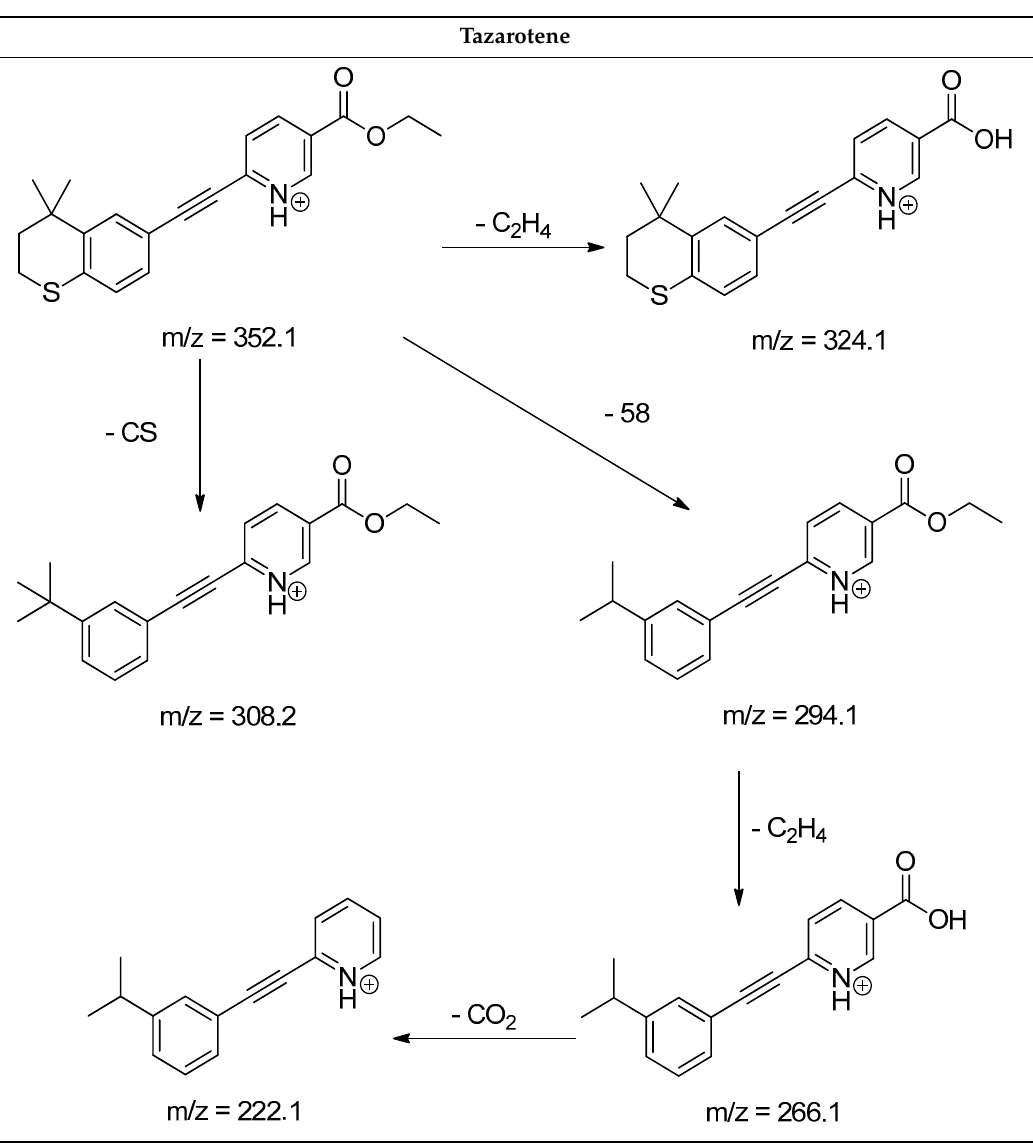
Table 2. Recommended fragmentation patterns.